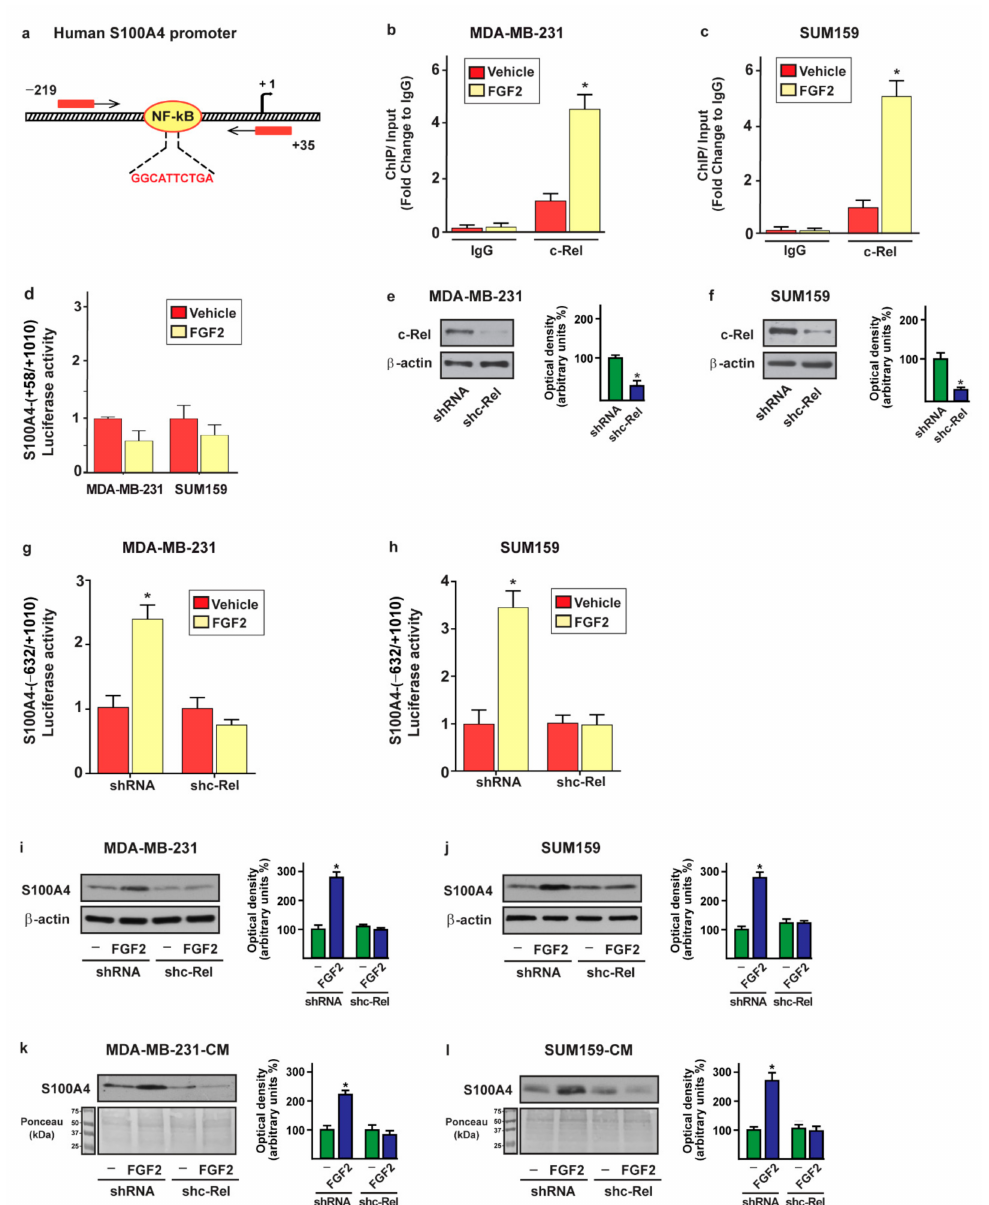
Figure 6. c-Rel is involved in the upregulation of S100A4 levels prompted by FGF2 in MDA-MB-231 and SUM159 cells. ( a ) Schematic representation of human S100A4 promoter carrying the NF-kB-responsive site (the transcriptional start site is indicated as + 1). ( b , c ) The treatment for 2 h with 25 nM FGF2 induces the recruitment of c-Rel to the NF-kB site located within the S100A4 promoter region in MDA-MB-231 and SUM159 cells, as ascertained by chromatin immunoprecipitation (ChIP) assay. Data were normalized to the input and reported as fold changes with respect to IgG. Each column represents the mean ± SD of three independent experiments performed in triplicate. ( d ) Luciferase activities of the S100A4